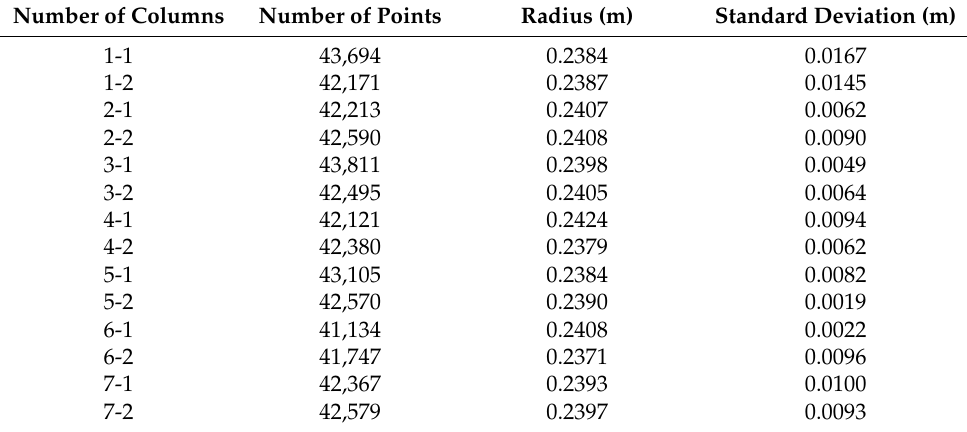
Table 2. Fitting